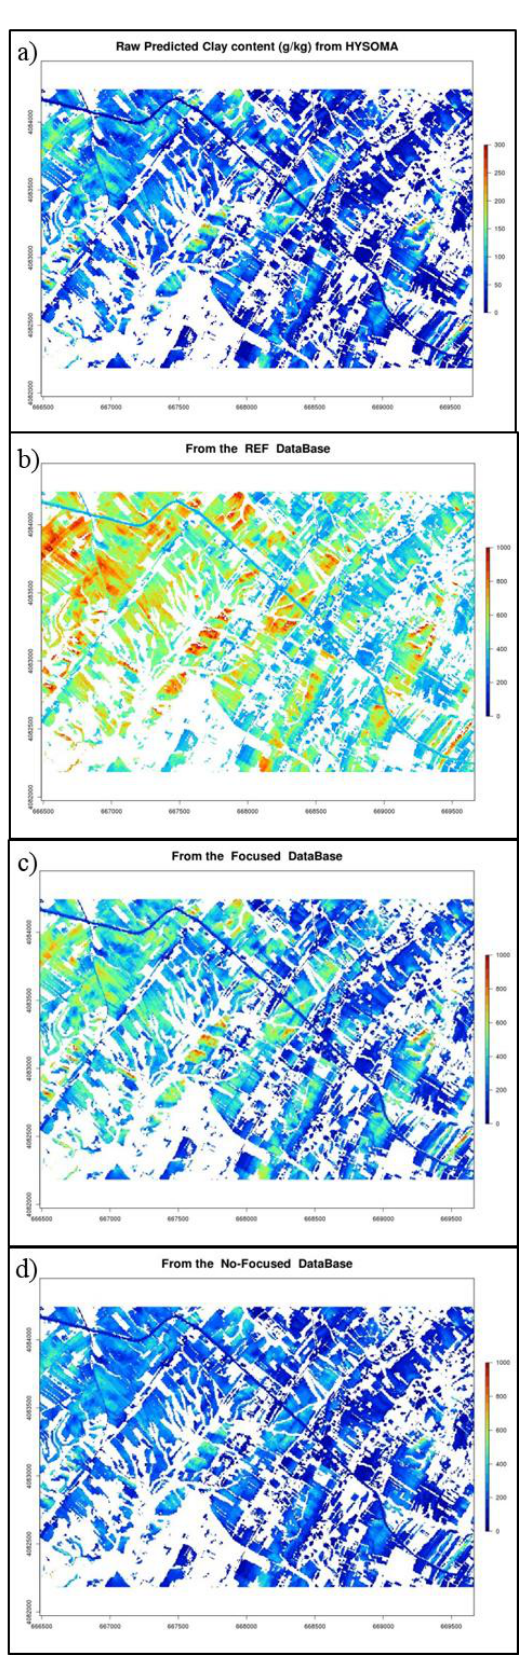
Figure 2: a) Raw_Map , b) Tr_REF_map , c) Tr_Focused_Map , and d) No-Focused_Map of Clay contents